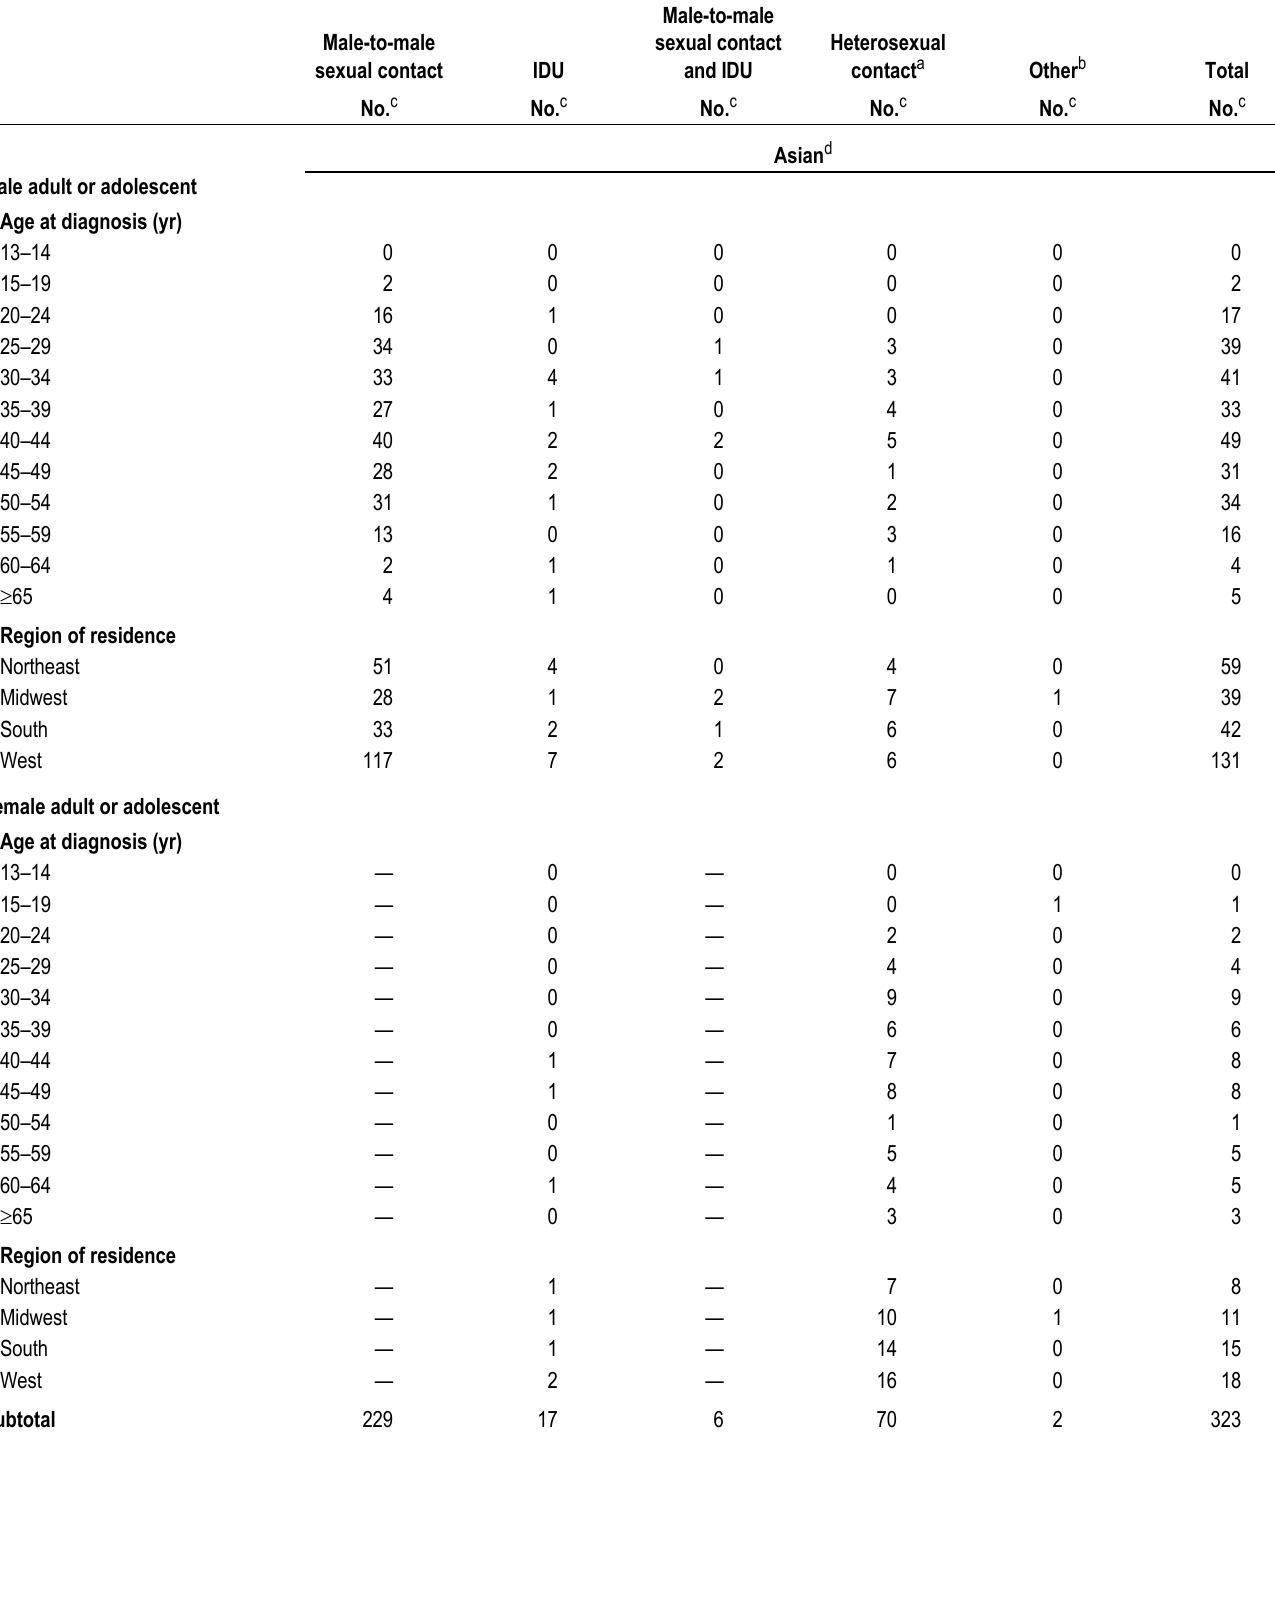
Table 6a. Stage 3 (AIDS), by transmission category, race/ethnicity, and selected characteristics, 2015—United States